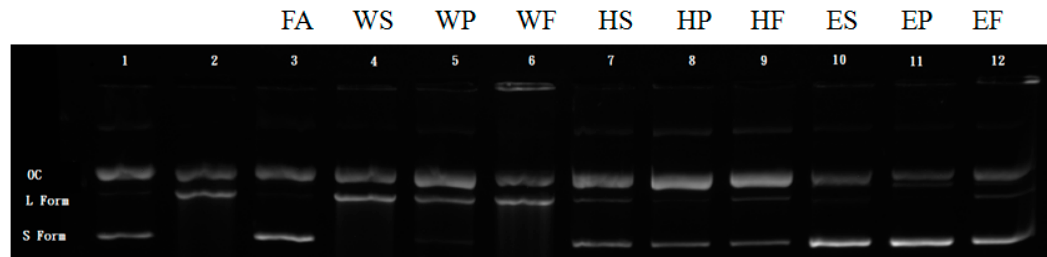
Figure 3. DNA damage protection assay results for crude extracts of Hylocereus polyrhizus parts. All wells contained 1 µ g pUC119 plasmid. Well 1 and 2 did not have any test sample and served as (+/ − ) controls. Well 3 had 0.3 mg/mL ferulic acid (FA). Well 4–12 were added with 3mg/mL